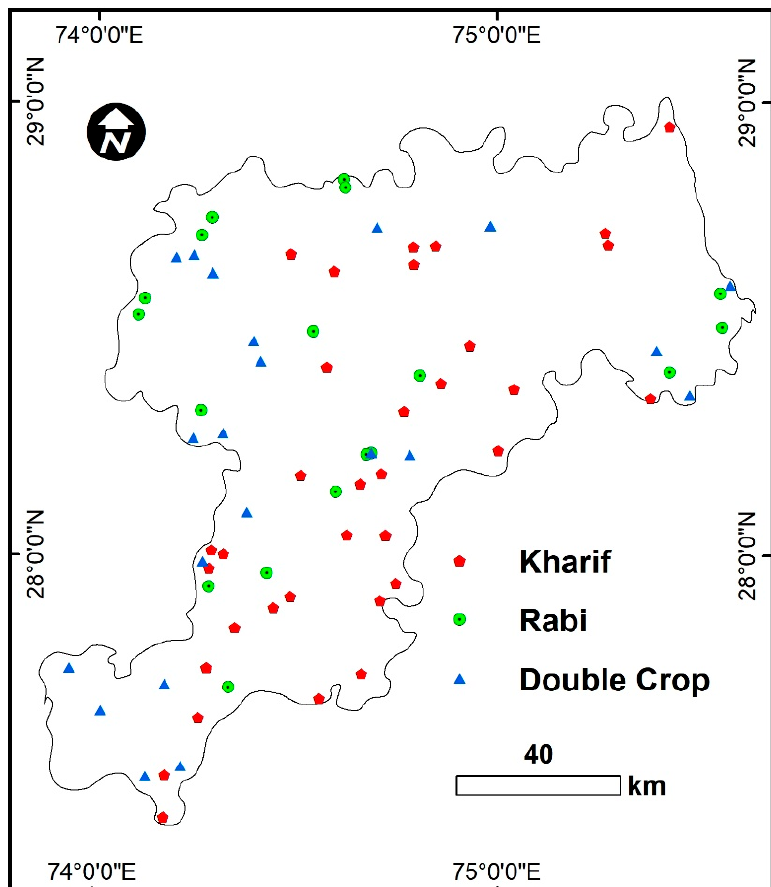
Figure 12. Ground validation points (Datum: WGS84). Table 2. Confusion matrix.